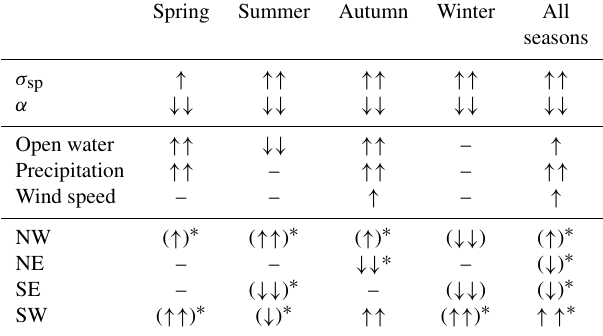
Table 1. Schematic to aid the reader in the discussion related to the observed trends in aerosol light scattering properties and results from the trajectory analysis. Arrows correspond to the sign of the trends. Single arrows are given when the average of the two meth- ods is greater than 1% or statistically significant. Double arrows display trends where the average trend is more than 2%. The aster- isk corresponds to non-statistically significant results from the least squares method (LMS). The brackets correspond to non-statistically significant results from the Mann–Kendall (MK) test. The scatter- ing Ångström exponent uses wavelengths of λ = 450 and 550nm, while the particle light scattering coefficient is given for the 550nm